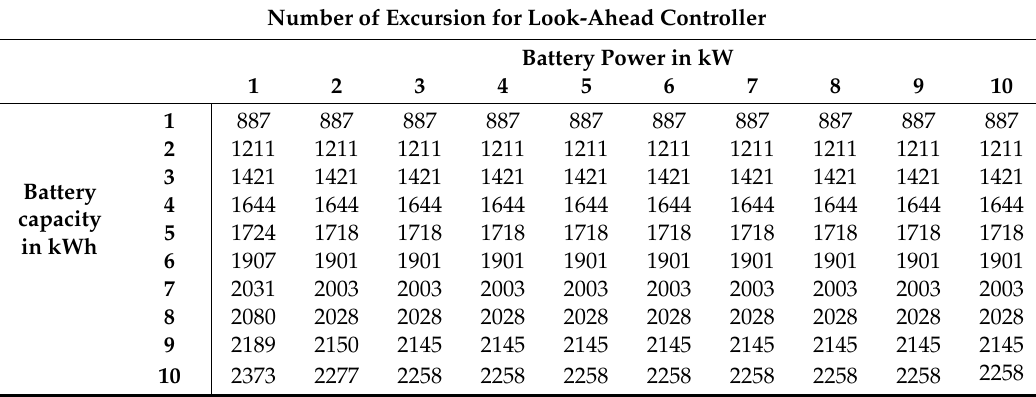
Table A3. Number of excursions for look-ahead